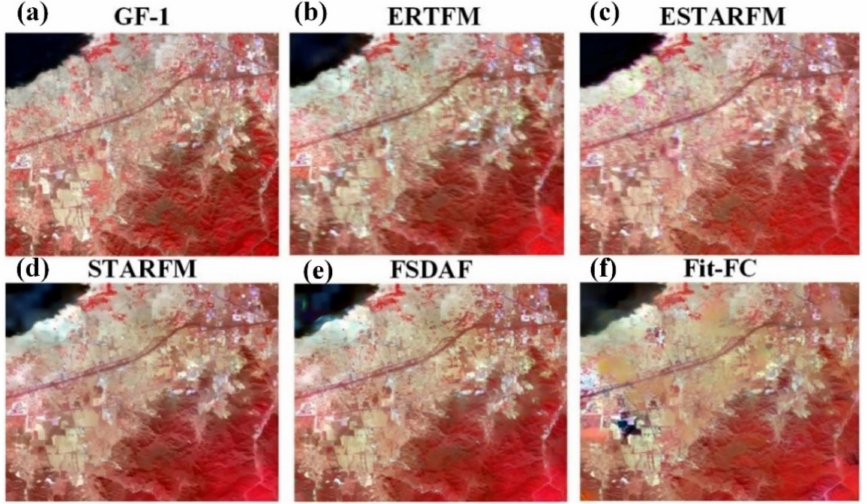
Figure 6. False color composites (RGB) of reflectance observed on the date of 2016/121 by: ( a ) GF-1; ( b ) ERTFM; ( c ) ESTARFM; ( d ) STARFM; ( e ) FSDAF; ( f )